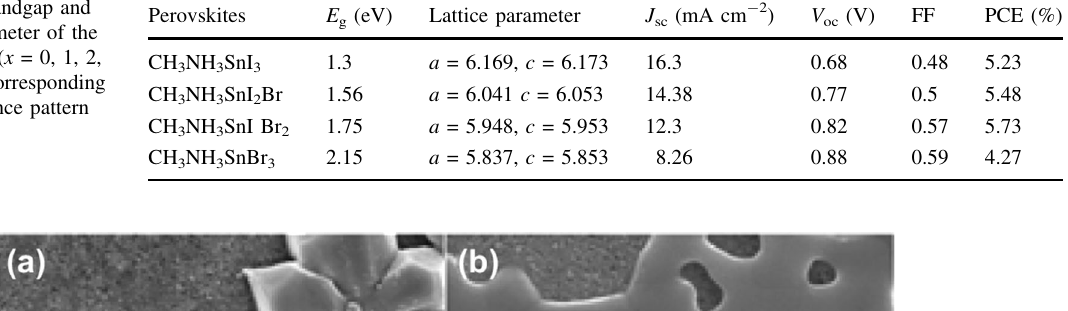
Table 8 Optical bandgap and refined lattice parameter of the CH